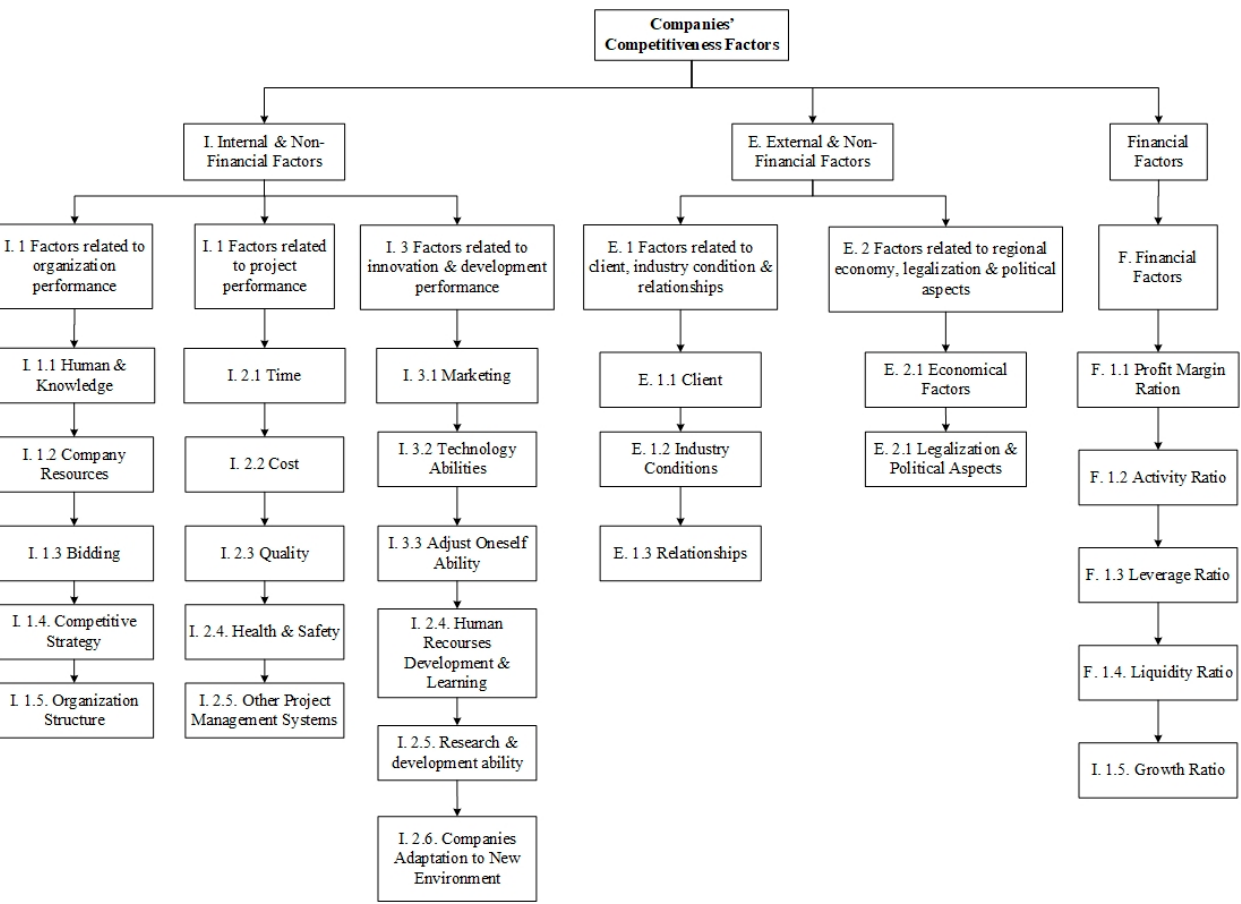
Figure 2. Hierarchy of critical success factors of companies’ competitiveness.